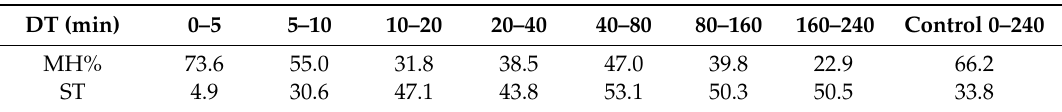
Table 5. Chemical families of Juniperus excelsa essential oil (EO) constituents as a function of their elution during hydrodistillation timeframes. DT